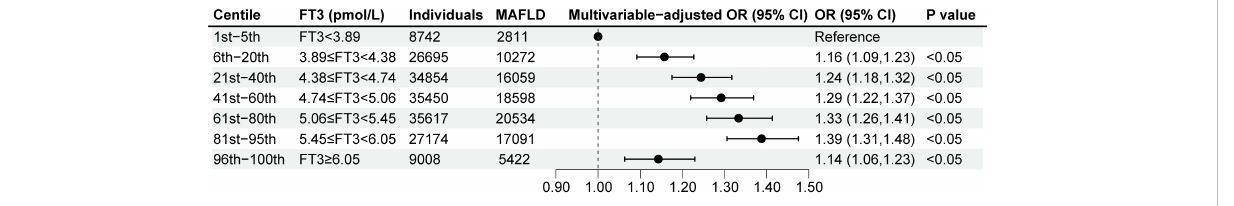
FIGURE 3 Multivariable-adjusted logistic regression analyses for MAFLD according to FT3 levels by the prior-de fi ned centile categories. Analyses were adjusted for age, sex, heart rates, leukocyte counts, red blood cells, platelets, hemoglobin, gamma-glutamyl transpeptidase, estimated glomerular fi ltration rate, uric acid, total cholesterol, smoking status, alcohol consumption, and a history of diabetes and hypertension. FT3, free triiodothyronine; MAFLD, metabolic dysfunction-associated fatty liver disease; OR, odd ratio; CI, con fi dence